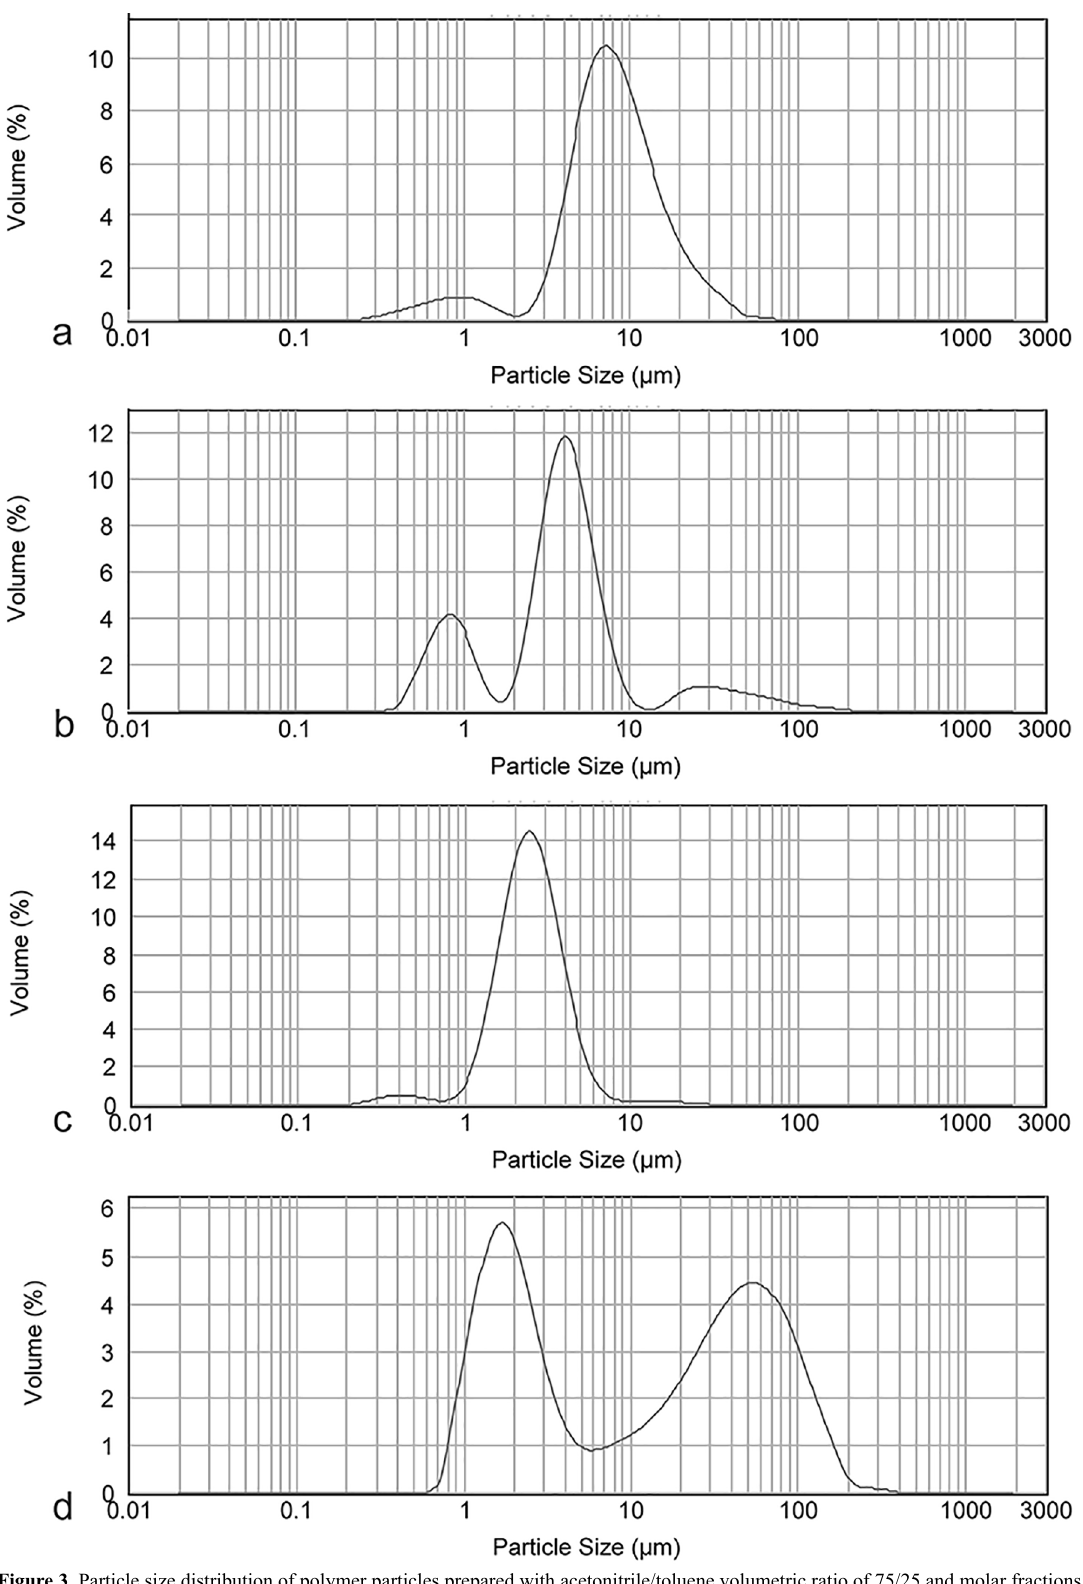
Figure 3. Particle size distribution of polymer particles prepared with acetonitrile/toluene volumetric ratio of 75/25 and molar fractions of: (a)14% MAA, (b) 23% MAA, (c) 50% MAA and (d) 80%